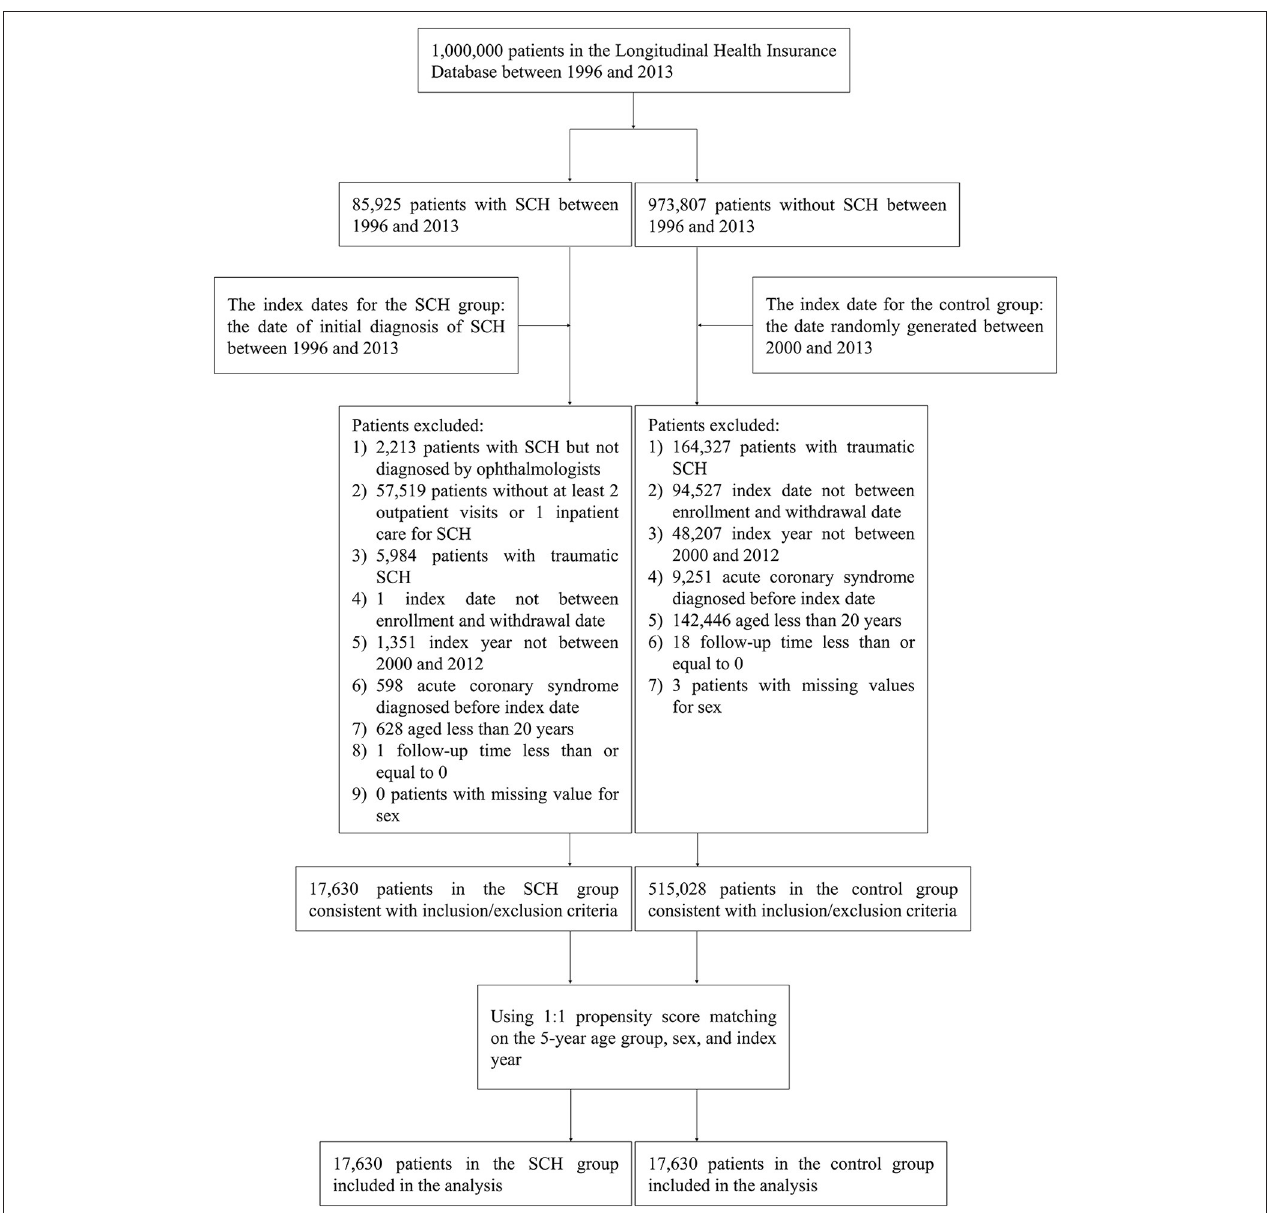
FIGURE 1 | Flowchart of the study population